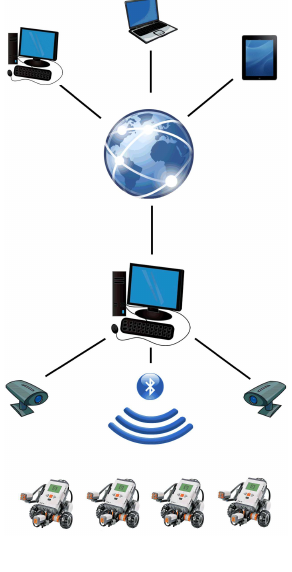
Figure 1. Hardware architecture.